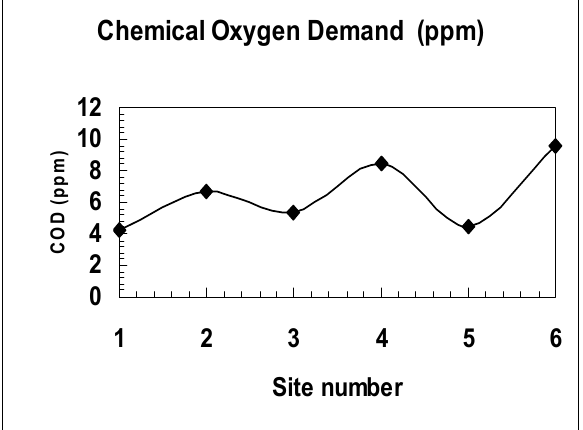
Figure 7 : Variation of COD with the site number . The line-diamonds are the experimental